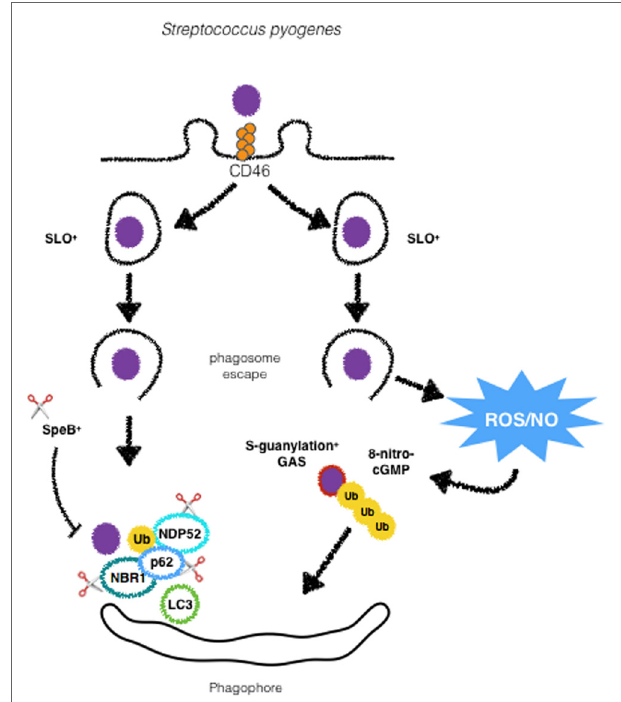
FigURe 2 | GAS is targeted by xenophagy by different mechanisms. Following activation of CD46, GAS is directed to autophagosomes. Streptolysin O promotes escape from phagosomes and ubiquitination and recognition by autophagic adaptors p62, NDP52 and NBR1. SpeB producing strains are able to degrade such adaptors to escape from xenophagy. GAS can also undergo modifications by ROS/NO-induced 8-nitro-cGMP via S-guanylation of its surface proteins followed by ubiquitination and targeting to